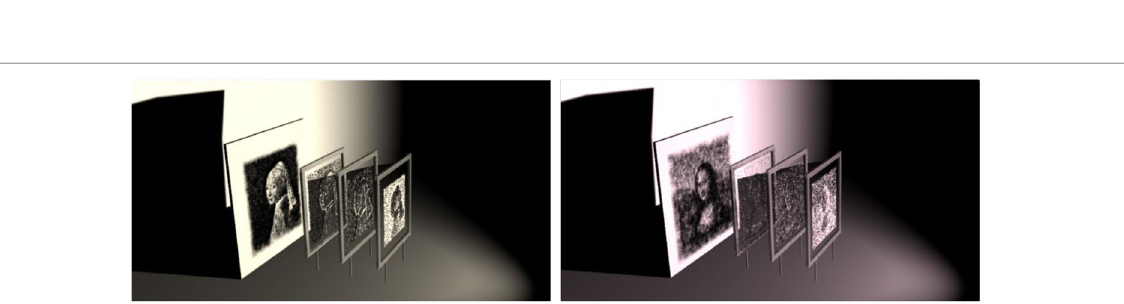
Fig. 4 Each layer of the object casts its shadow onto the receiver to form the target image